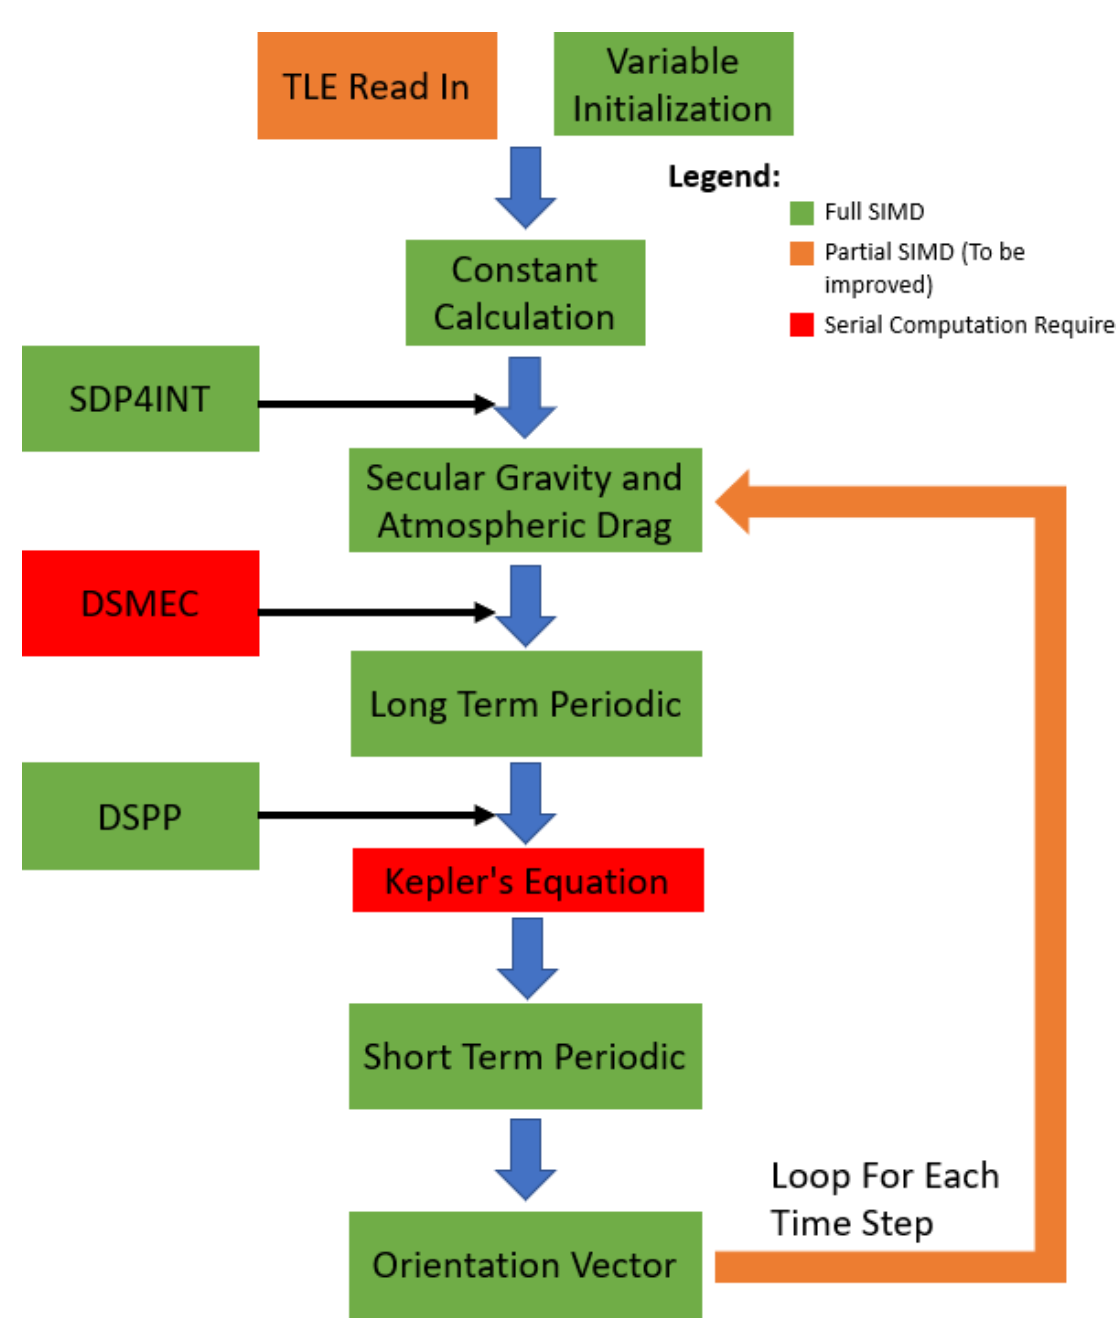
Figure 2. PSGP4 Algorithm Block Diagram, where the color represents the different implementations of SIMD processing. On the left of the main flow, the additional PSDP4 functions are shown with the location of the implementation.